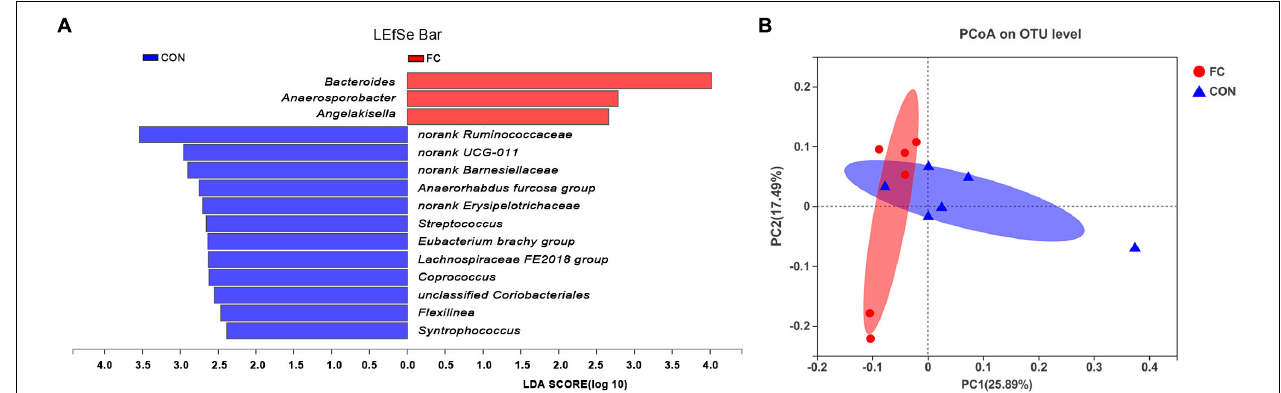
FIGURE 4 | Differences between bacterial taxa in follicular cyst ewes and normal follicle ewes. (A) The linear discriminant analysis (LDA) effect size (LEfSe) algorithm displayed significant differences between follicular cyst ewes and normal follicle ewes at genus level. (B) The principal coordinate analysis (PCoA) plots of the fecal microbiota based on the unweighted UniFrac showed the extent of variation in fecal microbial community between follicular cyst ewes and normal follicle ewes at OUT level. FC represents ewes with follicular cysts and CON represents ewes with normal follicle. Red bars represent OTU that are more abundant in follicular cyst ewes’ fecal samples than in normal follicle